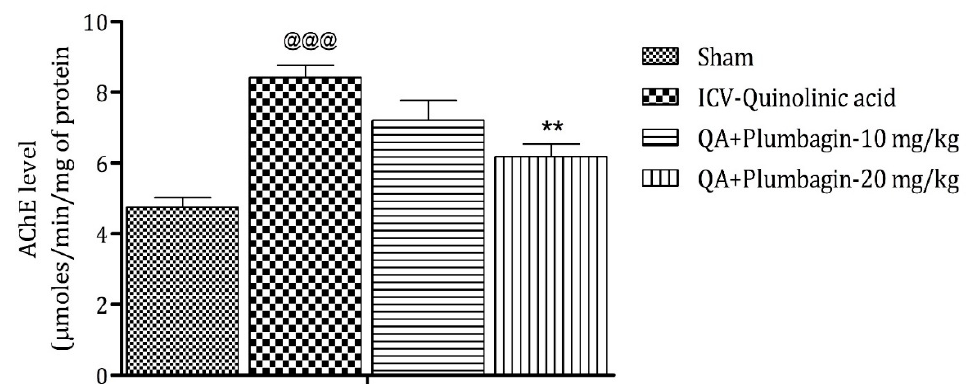
Figure 7. Effect of plumbagin on QA-induced variations in level of AChE for the determination of memory functions in rats. Data represent mean ± SEM ( n = 6). @@@ p < 0.001 as compared to sham group; ** p < 0.01 as compared to QA-induced group.